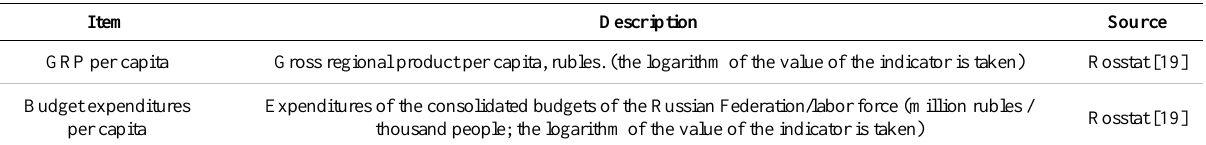
Table 3. Characteristics of indicators used to apply the scaling